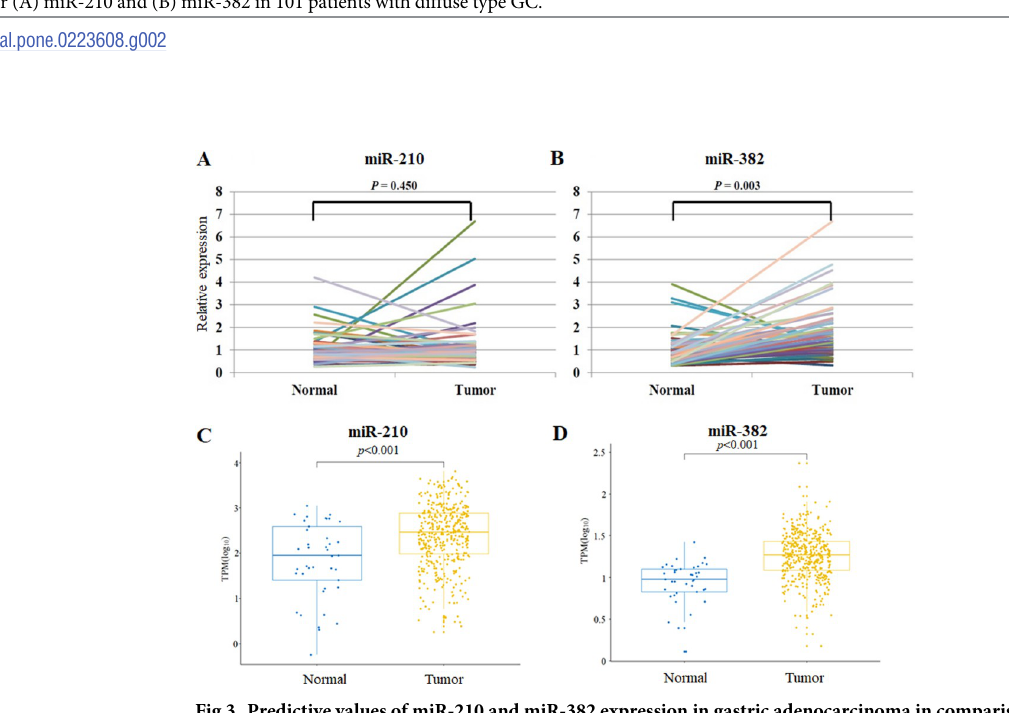
PLOS ONE | https://doi.org/10.1371/journal.pone.0223608 October 9,